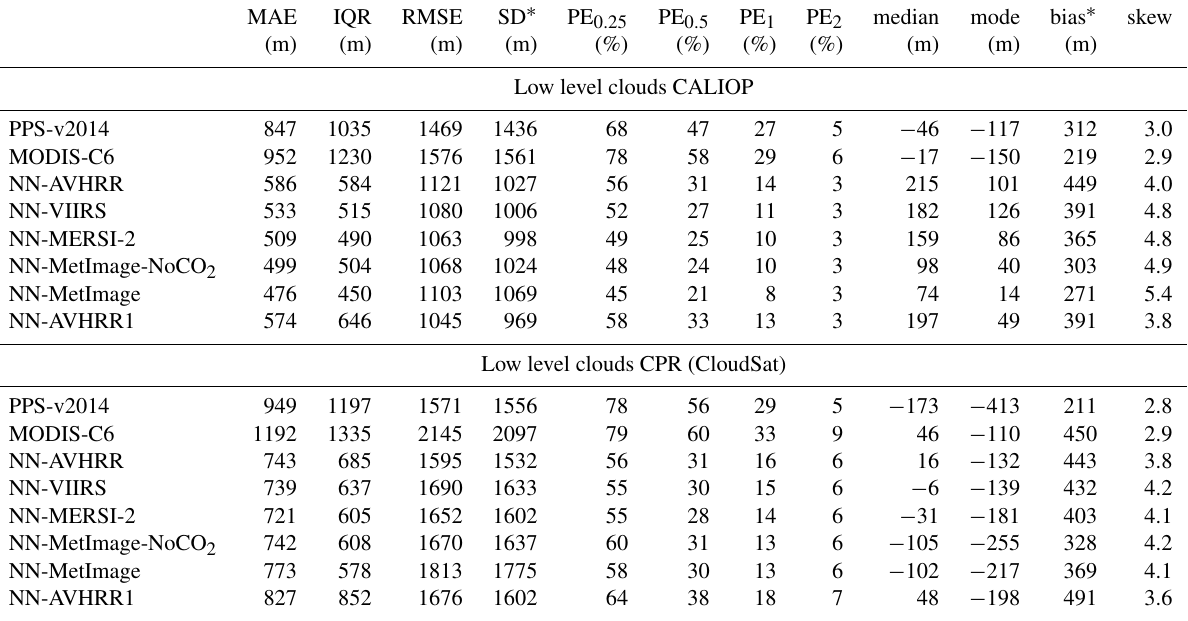
Table 7. Statistic measures for the error distributions for low level clouds. For all measures except skewness it is the case that values closer to zero are better. The statistics are calculated for 328015 matches for CPR (CloudSat) and 709434 matches for CALIOP. The low class comes from CALIOP feature classification flag (class 0, 1, 2 and 3) and for CPR (CloudSat) it is the pixels with heights lower or exactly at the NWP height at 680hPa. PE X describes percentage of absolute errors above X km, see Eq.